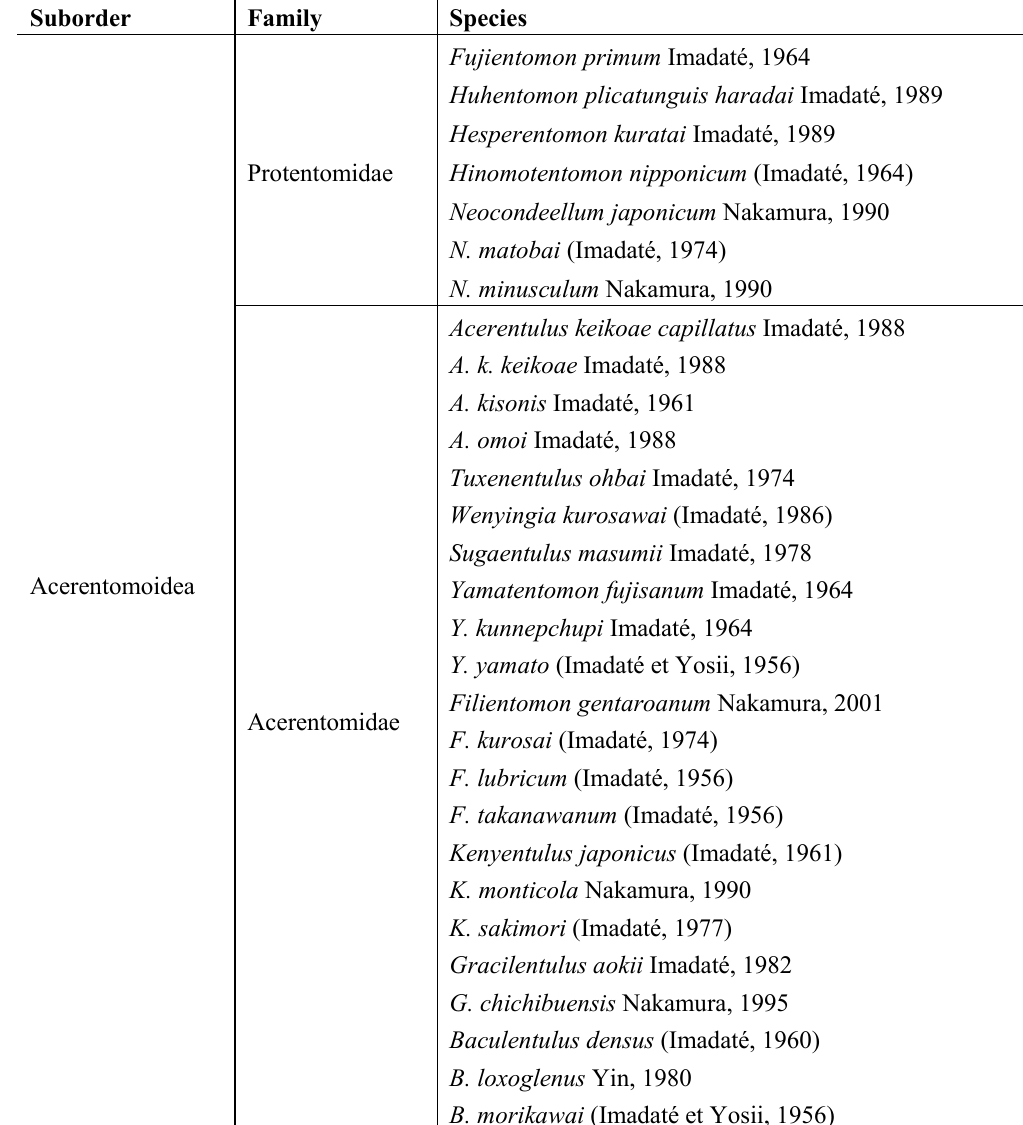
Table A1. Species list of Protura recorded in the data